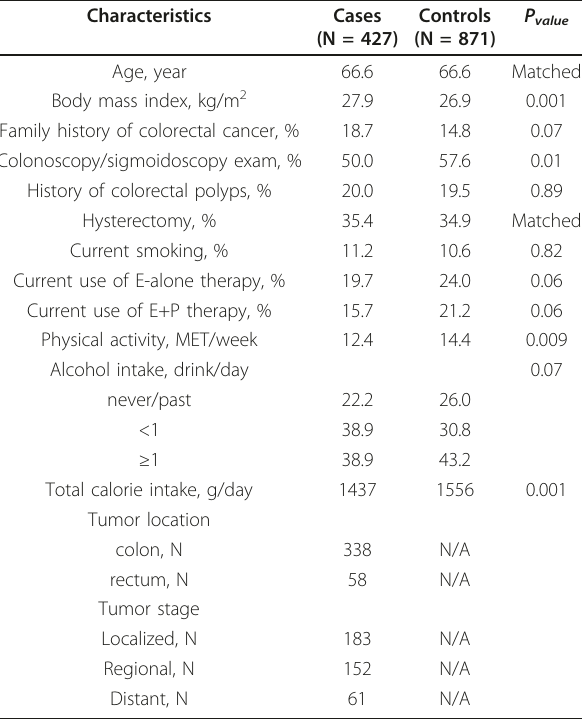
Table 2 Baseline characteristics (mean or %) among colorectal cancer cases and control subjects of Caucasians from the Women ’ s Health Initiative Observational